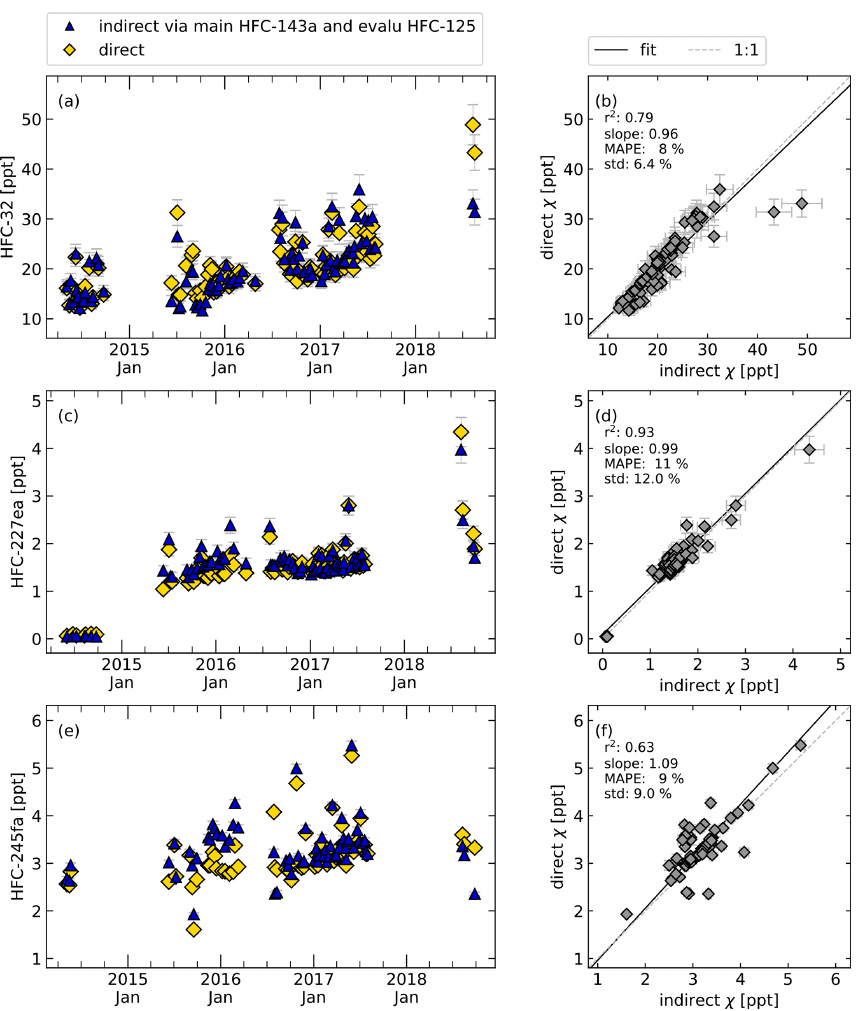
Figure 6. Time series (a, c, e) and correlations (b, d, f) of the mole fractions of HFC-32, HCFC-227ea, and HFC-245fa calculated directly (yellow symbols) and indirectly (blue symbols) for the weekly flask sample measurements. HFC-143a was used as main reference substance and HFC-125 as evaluation substance to select data with constant rRF. Error bars, which indicate the measurement precisions, are included but are often smaller than symbol